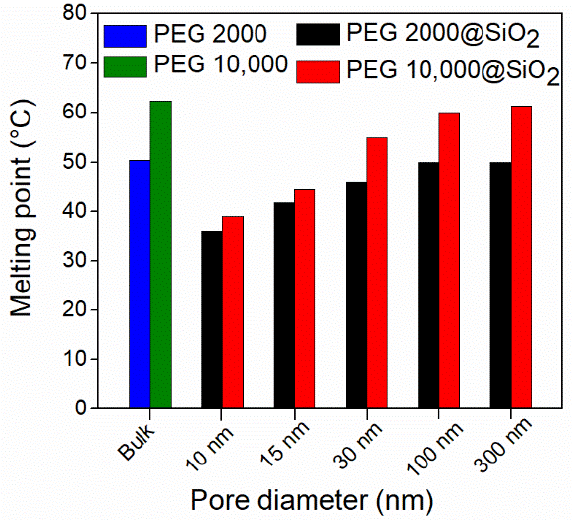
Figure 13. The melting temperature dependence on the pore size of the matrix for PEG 2000 and PEG 10,000 encapsulated into different pore size silica matrix or in bulk. Data from ref. [152].